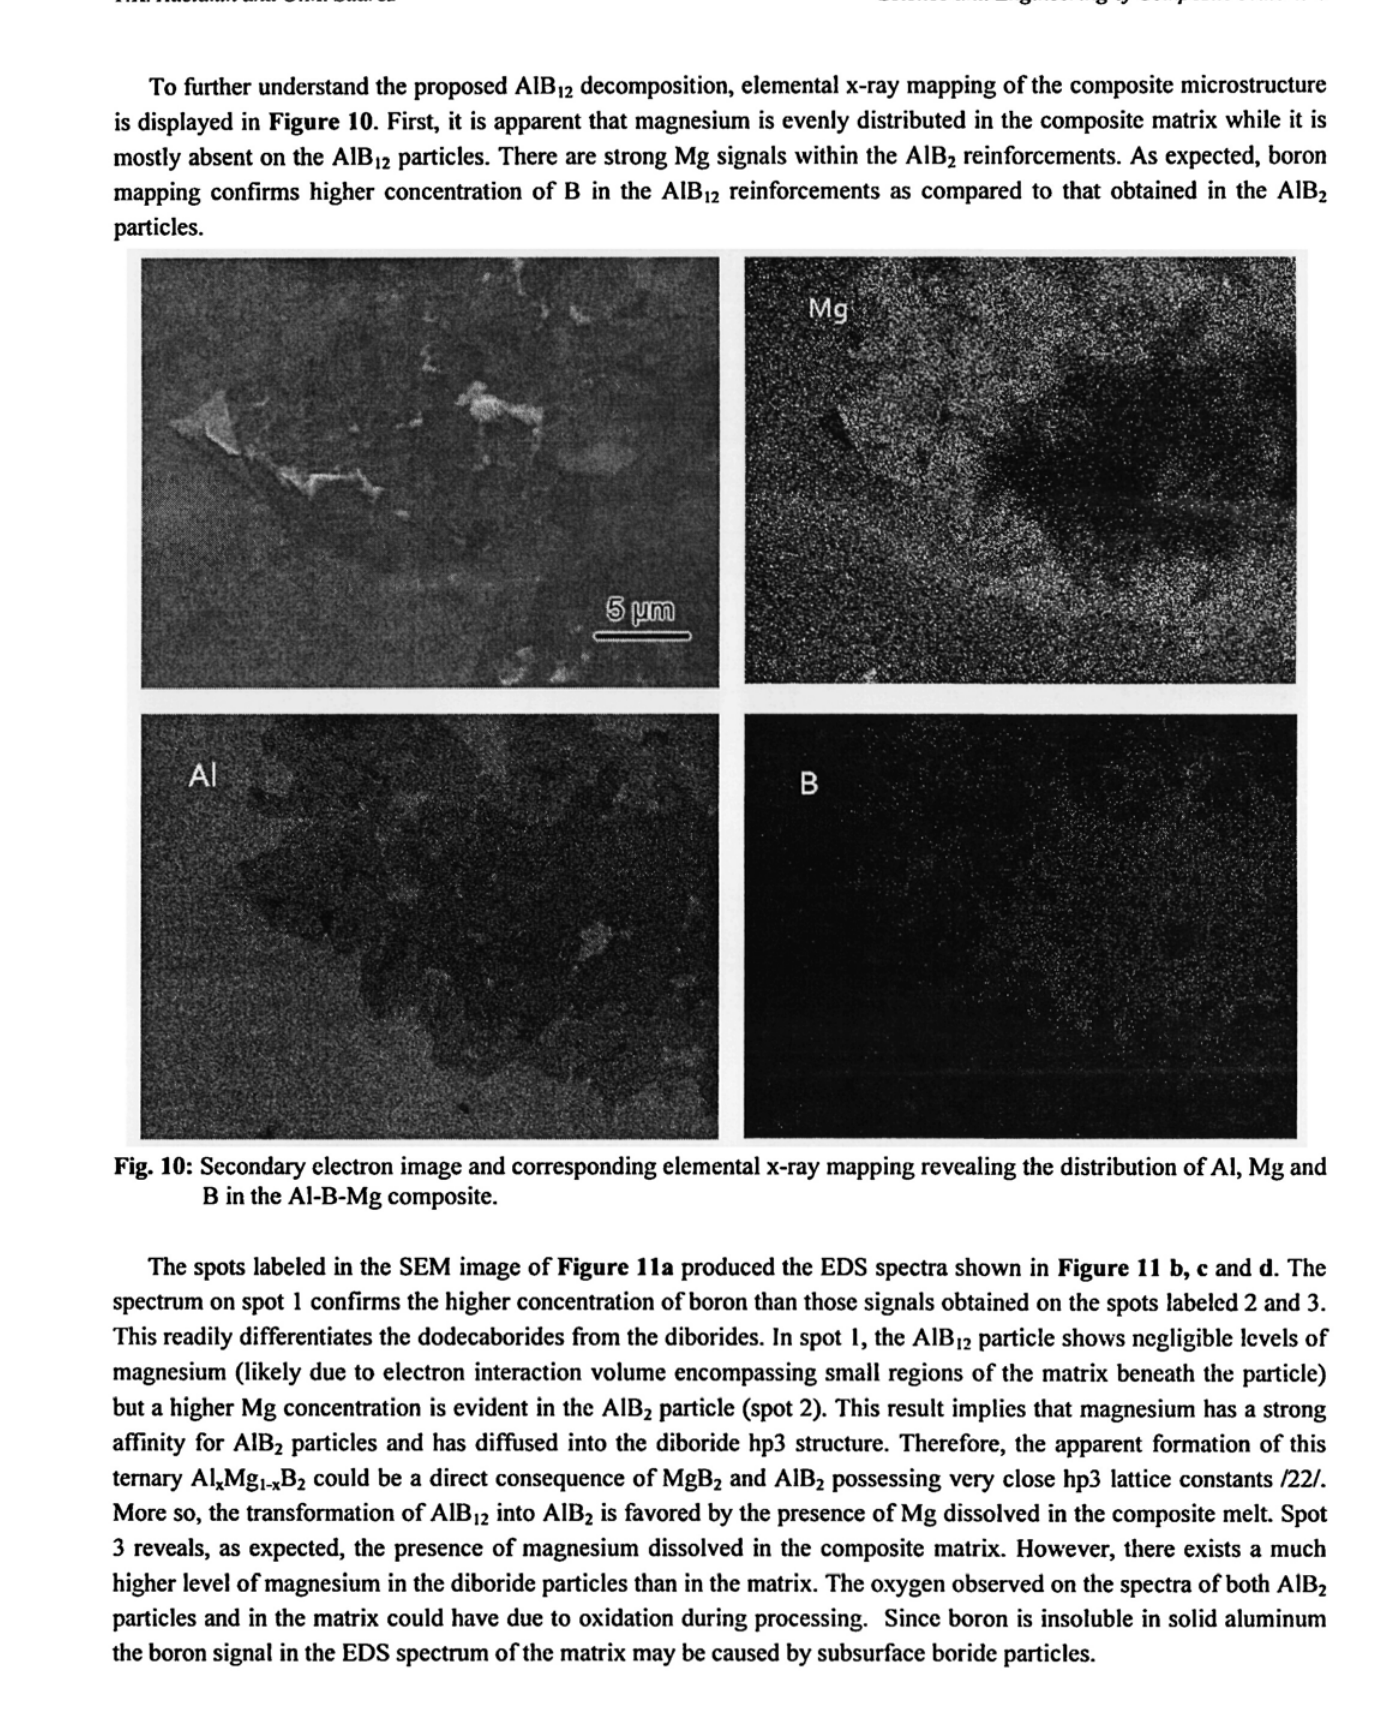
Fig. 10: Secondary electron image and corresponding elemental x-ray mapping revealing the distribution of Al, Mg and B in the Al-B-Mg